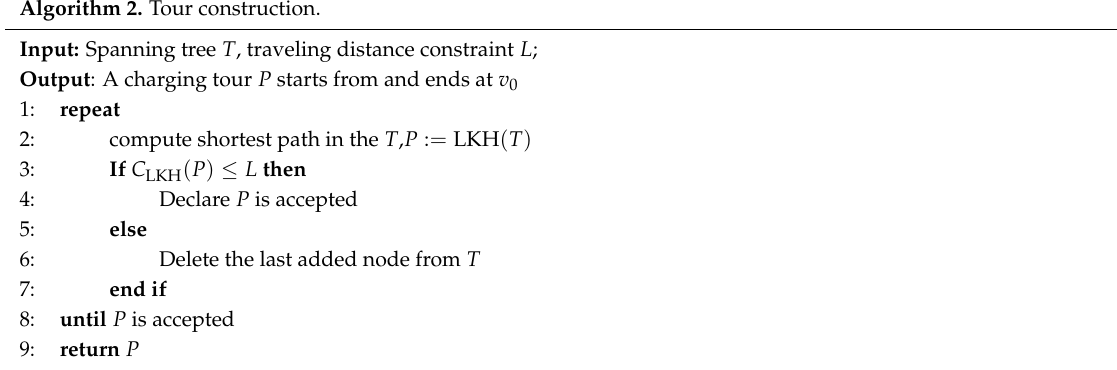
Algorithm 2. Tour construction.